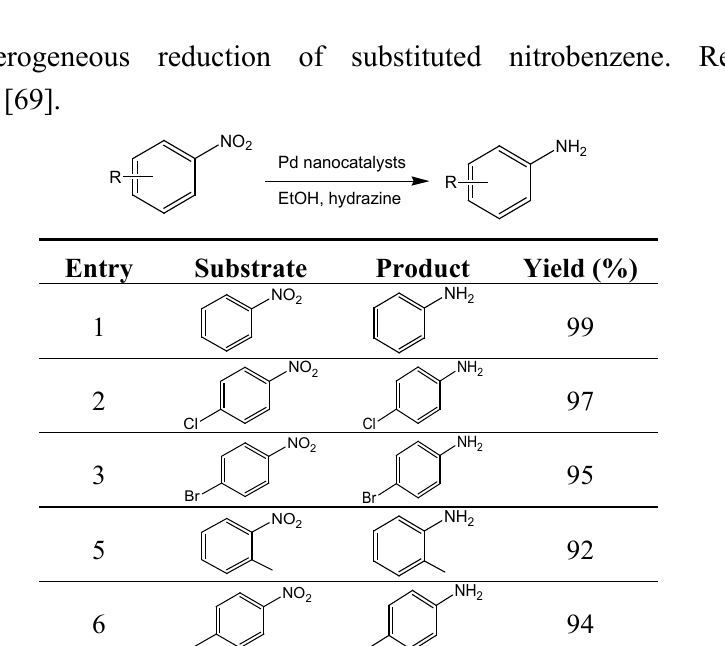
NO 2 NH 2 RPd nanocatalysts R EtOH, hydrazine Entry Substrate Product Yield (%) NO 2 NH 2 1 99 NH 2 NO 2 2 97 Cl Cl NH 2 NO 2 3 95 Br Br NO 2 NH 2 5 92 NO 2 NH 2 6